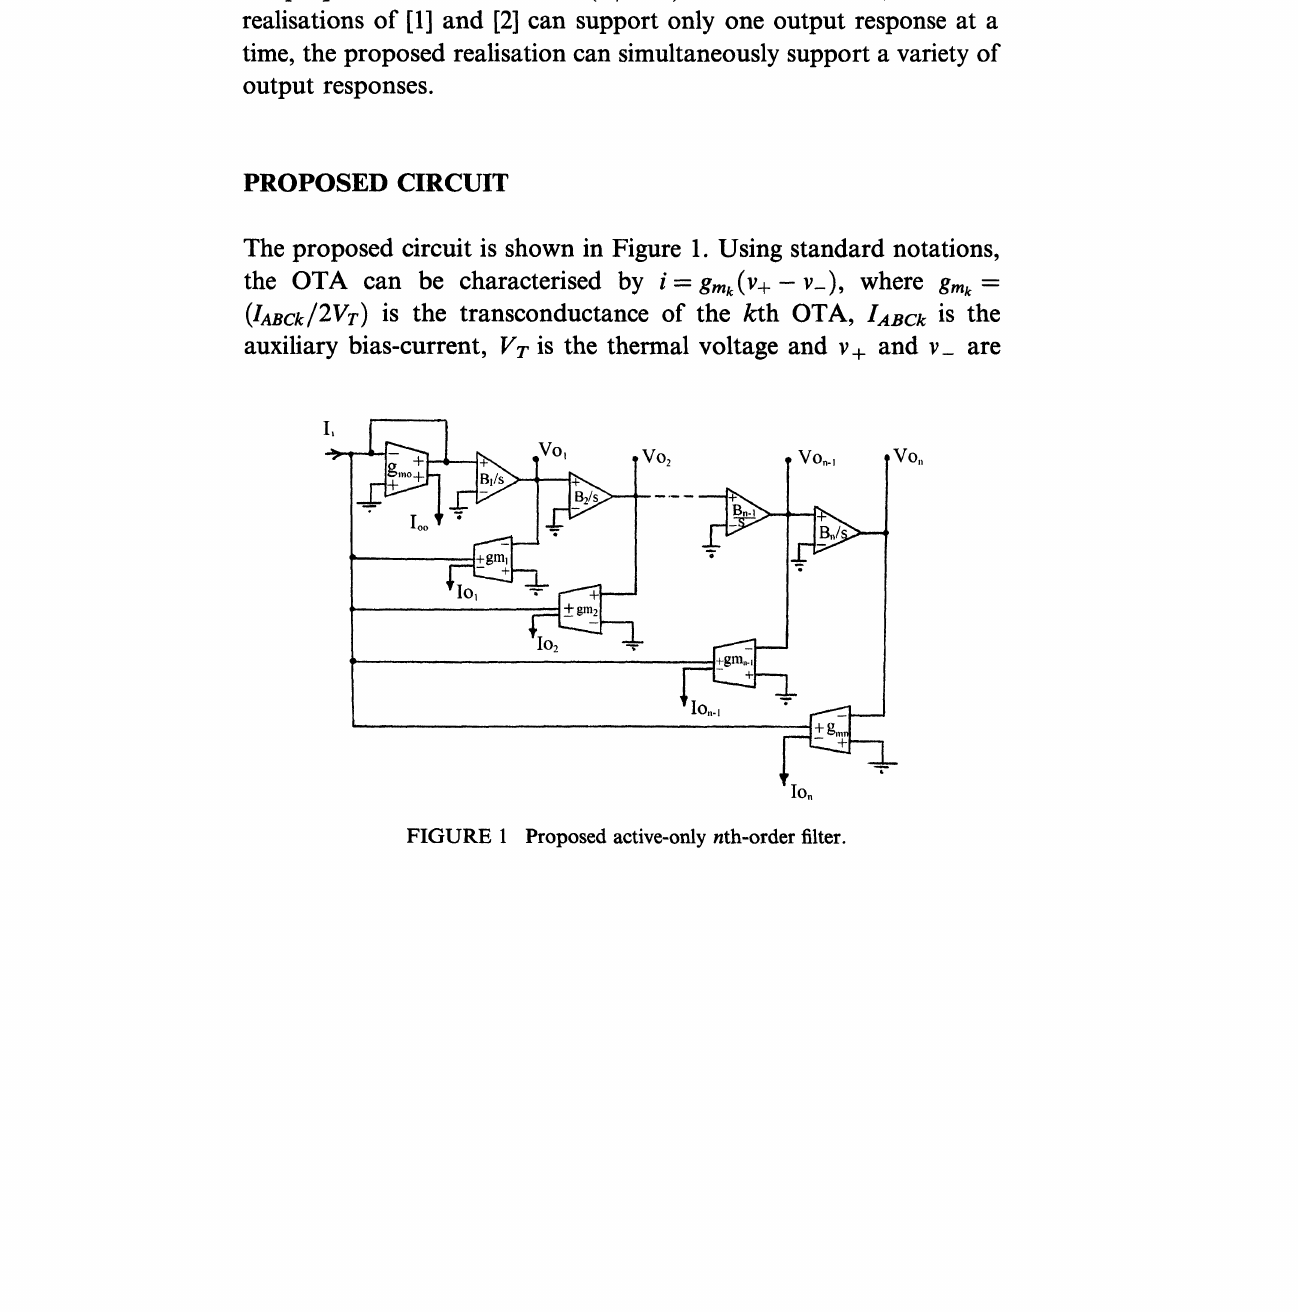
FIGURE Proposed active-only nth-order